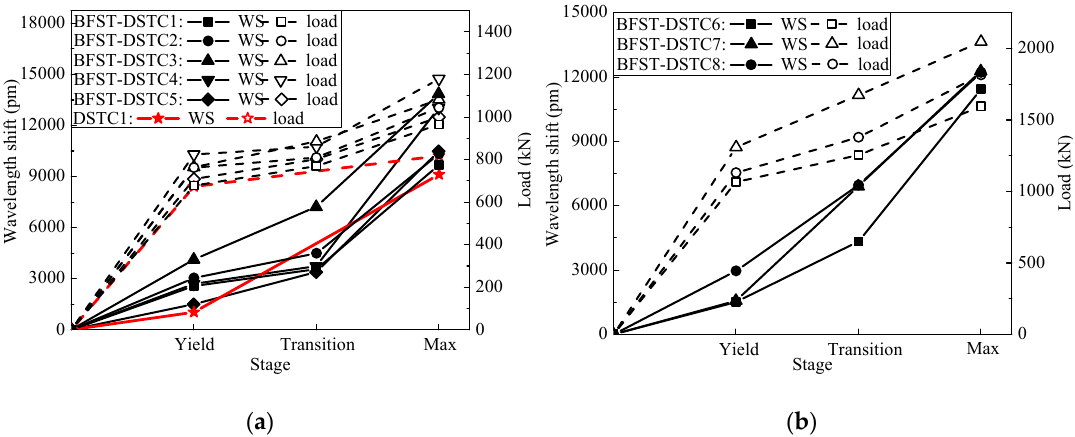
Figure 9. Relationship between the outer tubes’ WS and the load at each stage: ( a ) Specimens with NSC; ( b ) specimens with HSC.